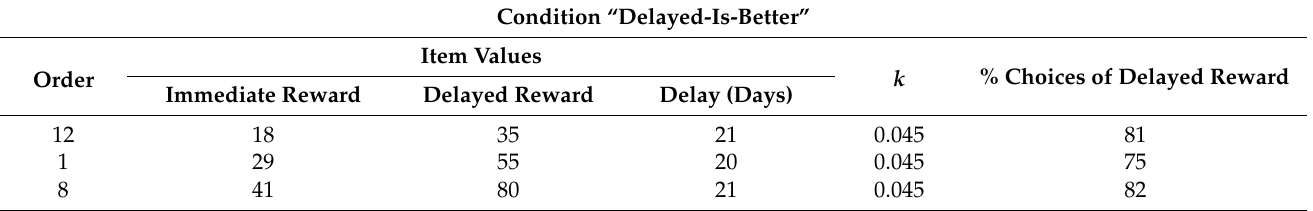
Table A1. Experiment 1 The monetary-choice questionnaire (MCQ) revised scale items with associ- ated discount parameter ( k ), order of presentation, and proportion of choices in the delayed